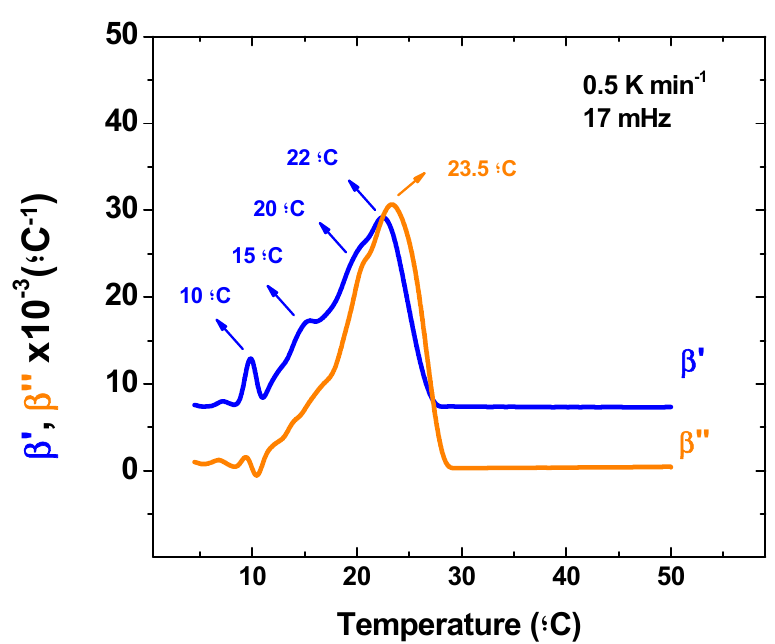
Figure 3. Temperature dependence of the dynamic thermal volume expansion coefficient. β ’ (blue line) and β ’’ (orange line). These quantities are acquired simultaneously with quantities pictured in Figure 2a,b.